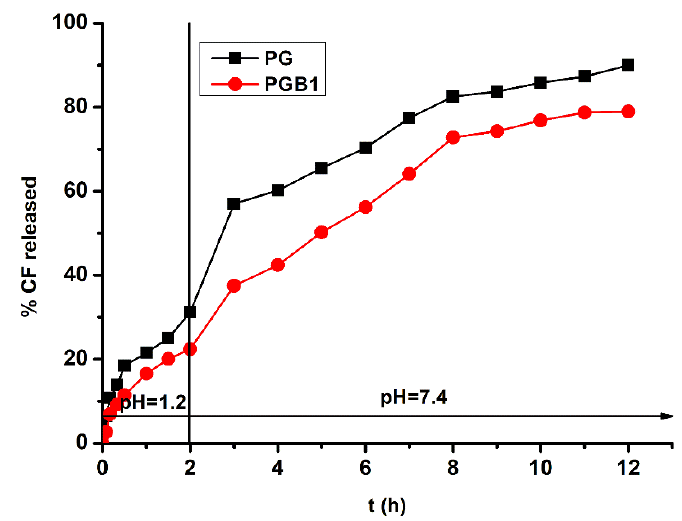
Figure 14. Release profile of cefotaxime sodium salt from PG and PGB1 samples.